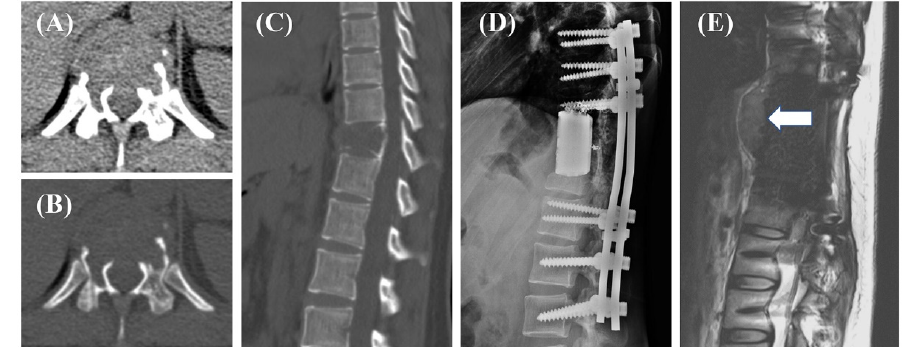
Figure 2. A 29-year-old female, axial ( A , B ) and sagittal ( C ) CT images showed the bone destruction of the T12, managed with total en bloc spondylectomy (TES, ( D )). Postoperative pathology suggested a high expression of RANKL in the tumor. The patient did not undergo radiotherapy. At a 10-month follow-up review, recurrence was detected (( E ), arrow).